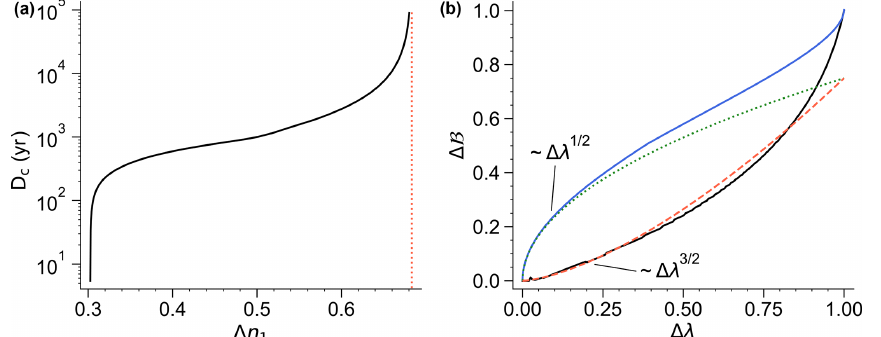
Figure 7. (a) Critical ramping duration below which there is a rate-induced tipping in the Stommel model when shifting the parameter from η 1 = 2 . 65 to η 1 = 2 . 65 + (cid:49)η 1 . The off attractor loses stability in the bifurcation at η off Normalized shortest distance to the basin boundary (cid:49) B as a function of the normalized distance to the bifurcation (cid:49)λ = ( η off η on ) − 1 . η on is the parameter value at the other saddle node bifurcation of the on state. The solid black curve shows the results of the Stommel 1 1 model, and a proposed super-linear scaling is shown by the dashed curve. Also shown are results for the smooth bifurcation in the sea ice component (solid blue) and the corresponding square-root scaling (dotted).